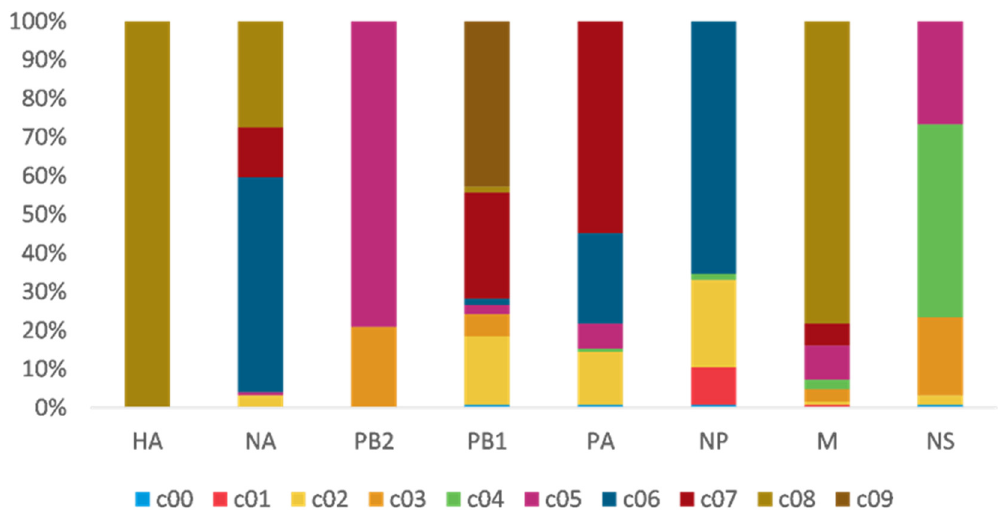
Figure 3. The gene clusters proportion of YRD-E. The same color and number in different segments are not correlative. PB2 c05 (79.03%) and M c08 (78.23%) are dominant clusters in the epidemic wave 5. Viruses have PB2 c05, and M c08 account for 62.10%.